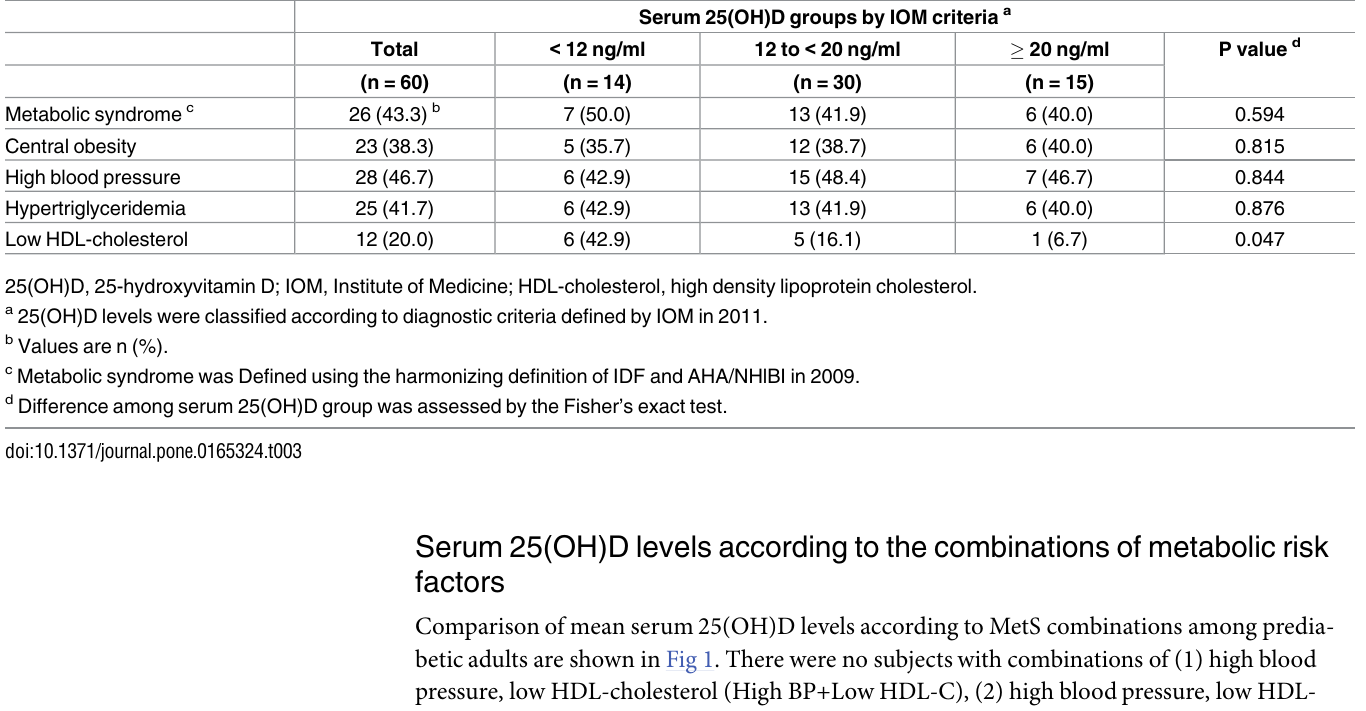
Table 3. Metabolic risk factors of Korean prediabetic adults by serum 25(OH)D level.